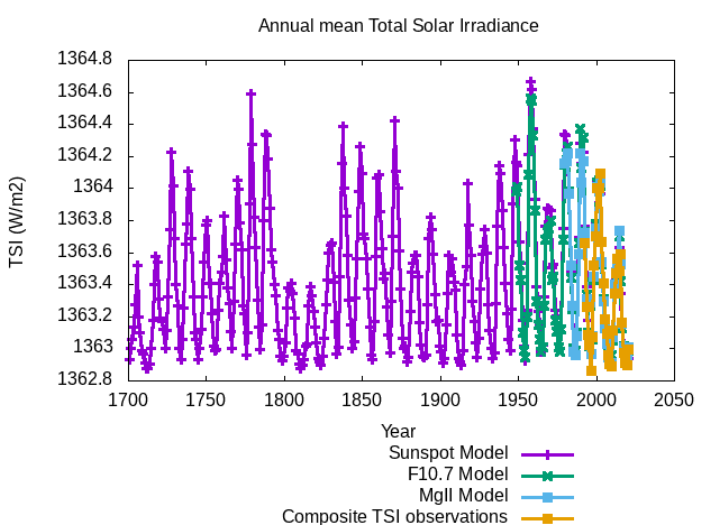
Figure 3. Orange curve: annual mean TSI observations from 1992 to 2020. Light blue curve: annual mean MgII-based TSI model from 1979 to 2020. Green curve: annual mean F10.7-based model from 1948 to 2020. Purple curve: annual mean SN-based model from 1700 to 2020.